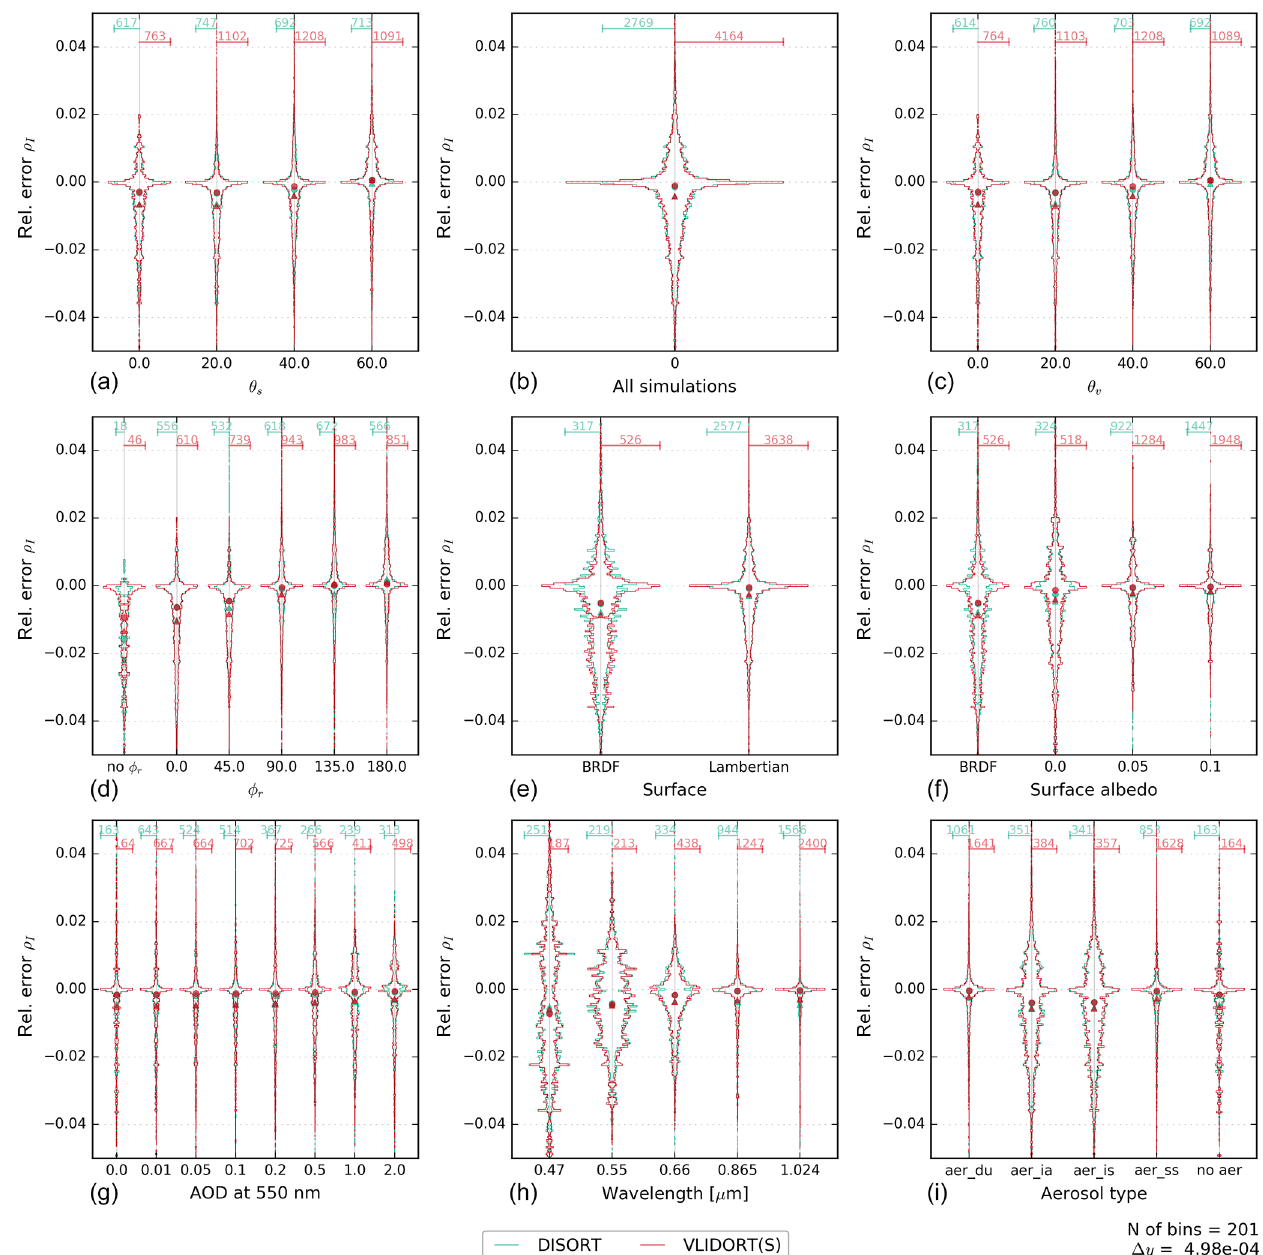
Figure 4. Same as Fig. 3 but for the relative error of the DISORT and VLIDORT (scalar) models against the vector version of VLIDORT. Please note the ± 5% error range on the y axis. The number of cases outside the range is indicated in Table 3. The width of the classes is (cid:49)y = 4 . 98 × 10 − 4 . Note that the scale used on the x axis is different for each violin plot but is the same for the two models within a violin